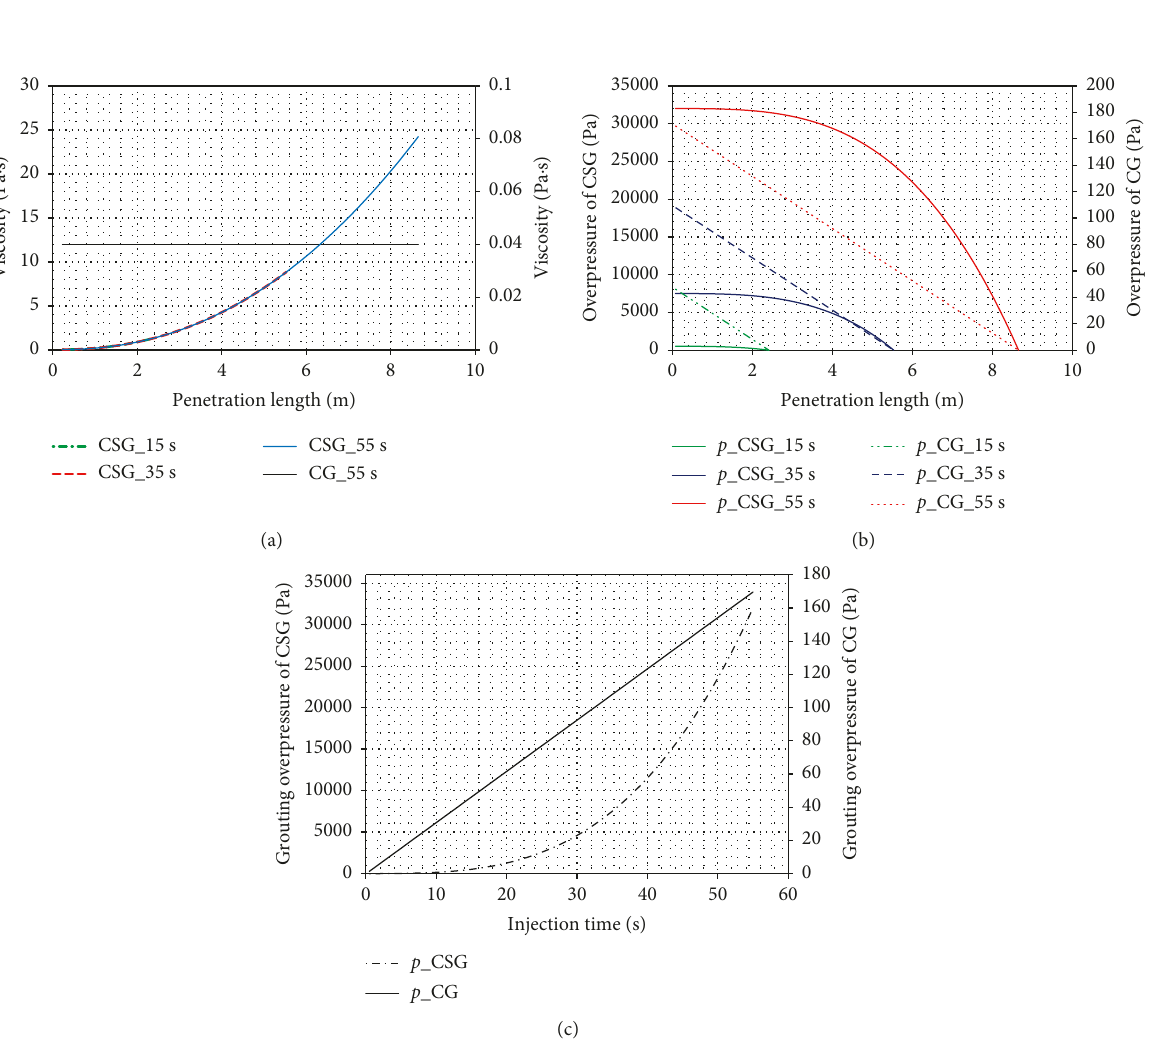
Figure 6: The calculation results for the flow rate control injection mode. (a) Viscosity distribution with penetration length at three grouting times, 15, 35, and 55s. (b) Overpressure distribution with penetration length at three grouting times, 15, 35, and 55s. (c) Variations in grouting overpressure with injection